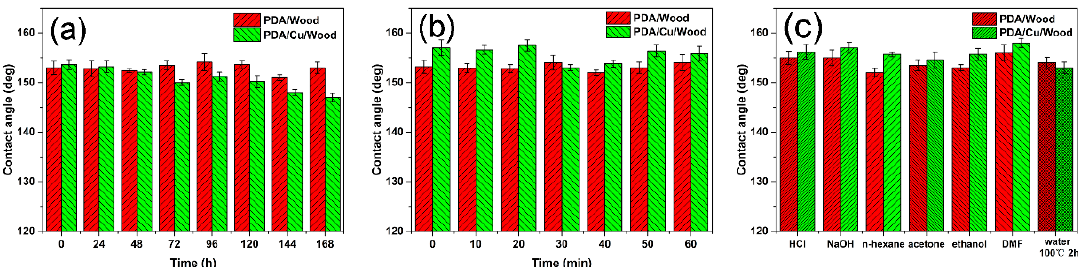
Figure 4. Environment durability characterization of PDA/Wood and PDA/Cu/Wood. ( a ) CAs as a function of UV radiation exposure time; ( b ) CAs as a function of time of ultrasonic washing in water; ( c ) CAs for wood samples soaked into different chemical solutions for 24 h.